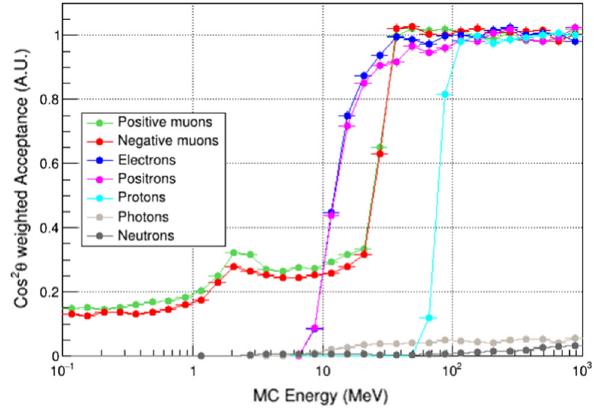
Fig. 7 POLAdetectoracceptanceweightedwithcos 2 θ andnormalised to the unity above 500 MeV as a function of Monte Carlo (MC) energy. The coloured lines and markers refer to different particle